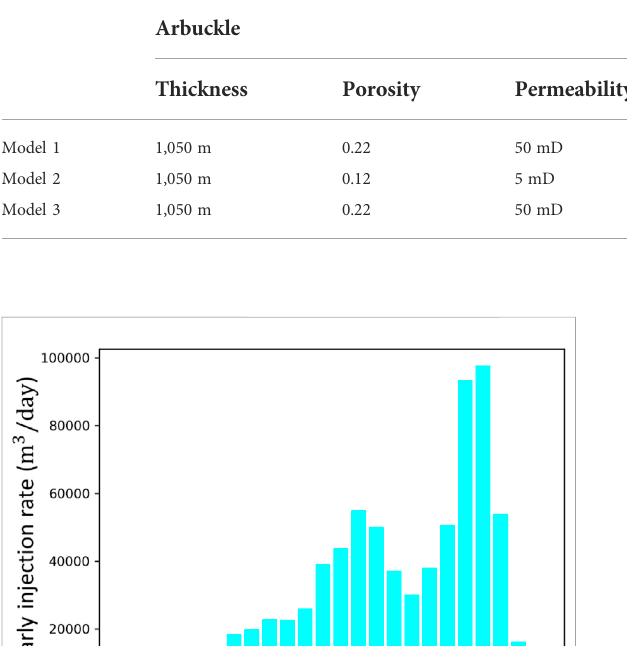
TABLE 1 Geometry and model parameters of the fl ow simulation models.